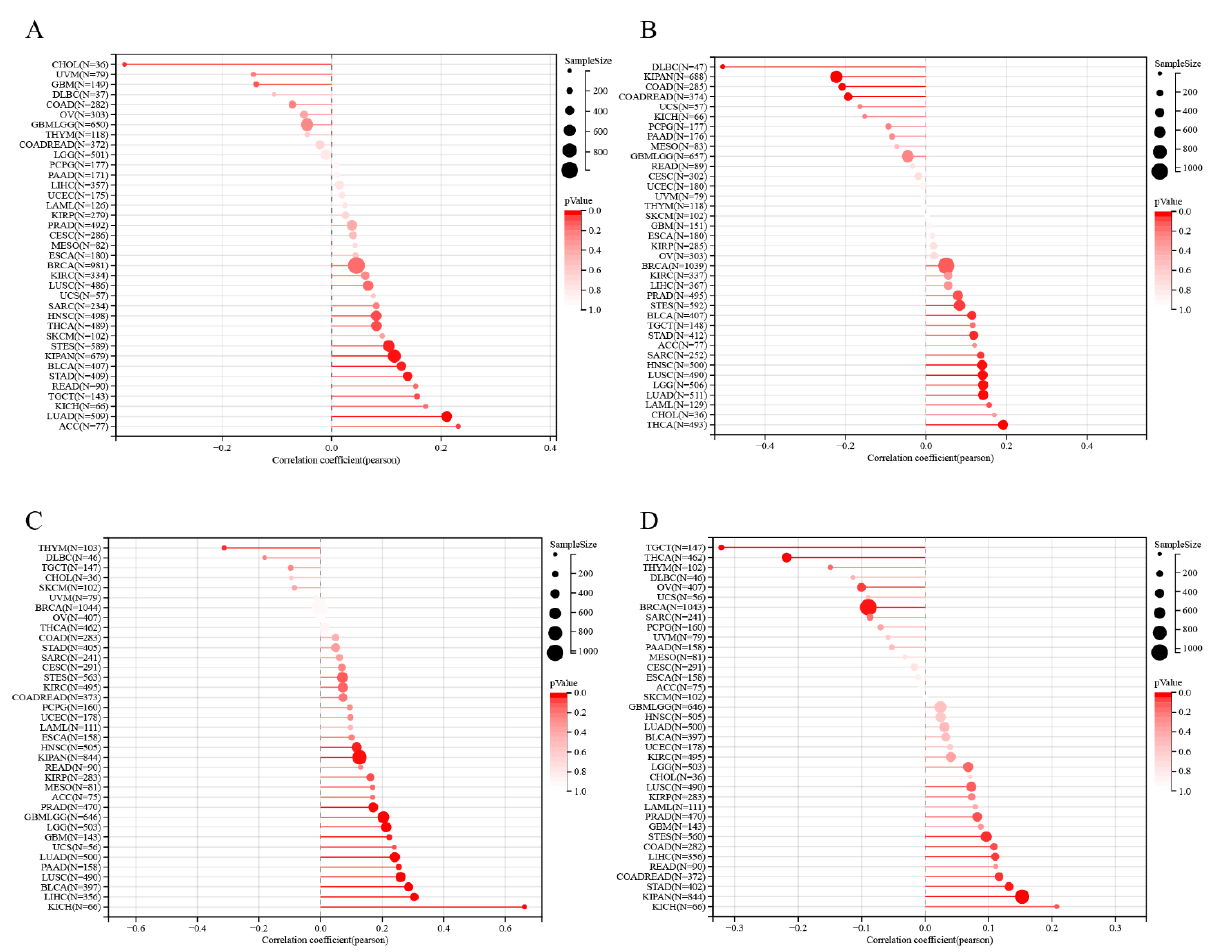
Figure 4. Correlation of MITD1 expression with Tumor mutational burden, microsatellite instability, homologous recombination deficiency, and ploidy. ( A ) the correlation between MITD1 and Tumor mutational burden. ( B ) The correlation between MITD1 and microsatellite instability. ( C ) The correlation between MITD1 and homologous recombination deficiency. ( D ) The correlation between MITD1 and